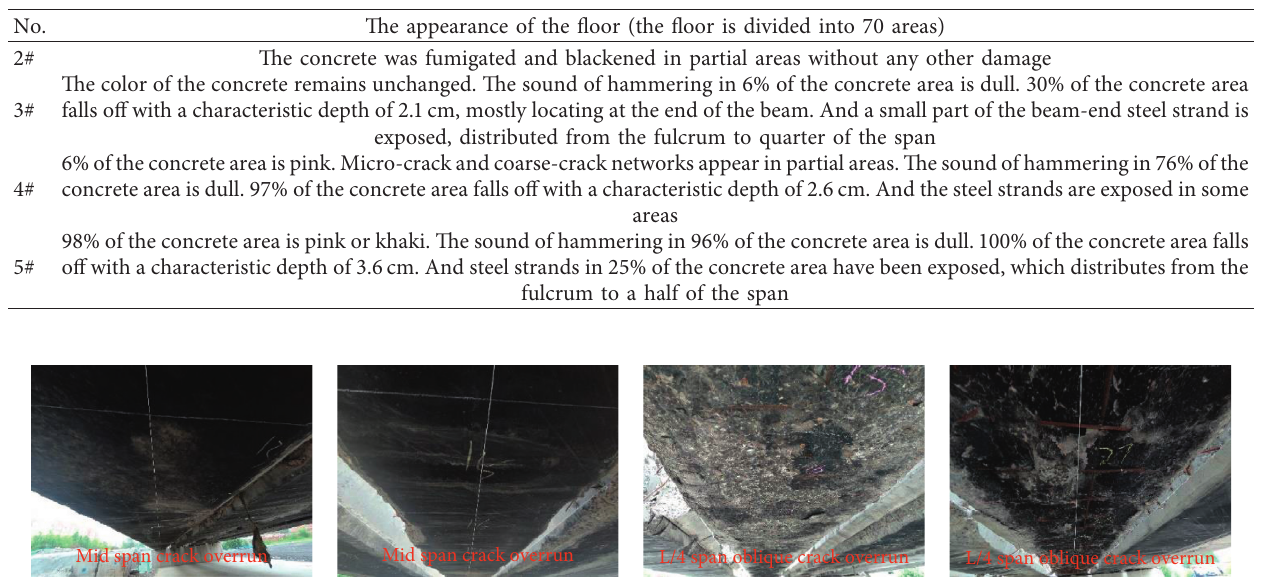
Table 2: The appearance of test beam.